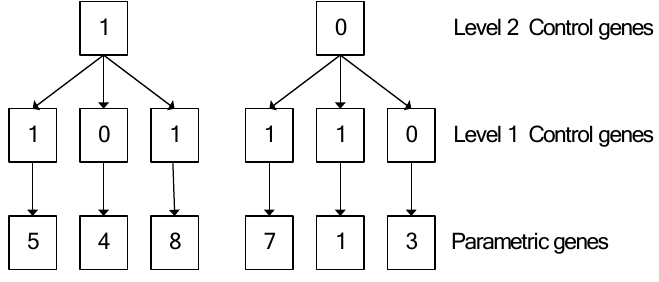
Figure 3. A three-level chromosome.